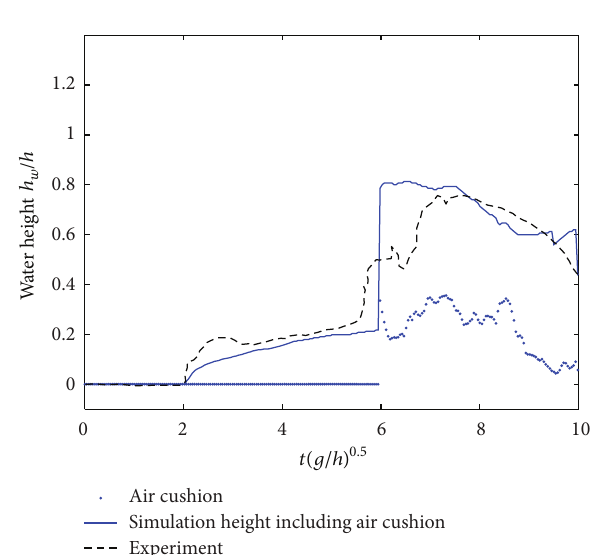
Figure 13: Effect of air on water height of